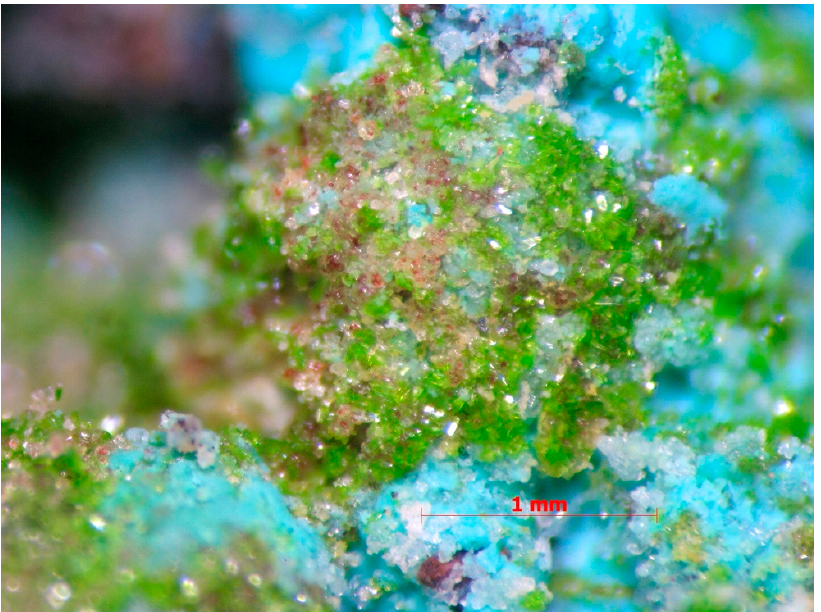
Figure 2. Crystals, crystal clusters and crusts of green dioskouriite with light blue chlorothionite and colorless carnallite and sylvite. The holotype specimen from the Glavnaya Tenoritovaya fumarole. Field of view width, 3.5 mm.